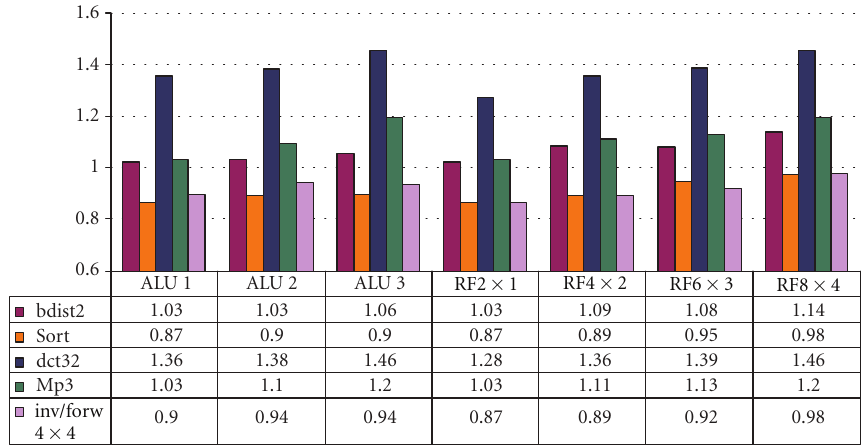
Figure 10: Relative cycle time for nonpipelined data paths generated for di ff erent resource